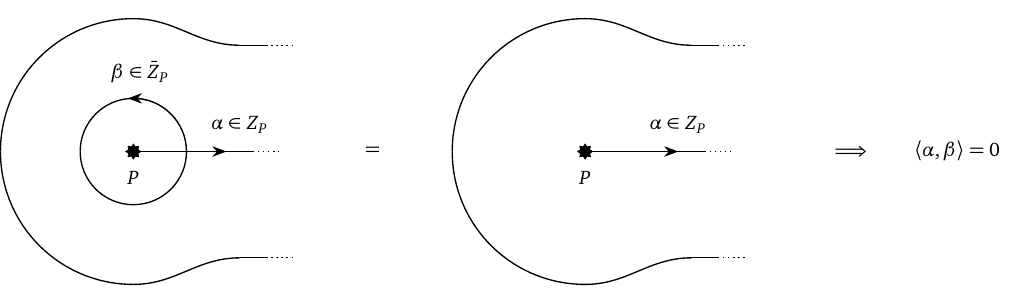
Figure 10: A 1-cycle surrounding a puncture of type P and carrying α ∈ ¯ Z trivial in L .